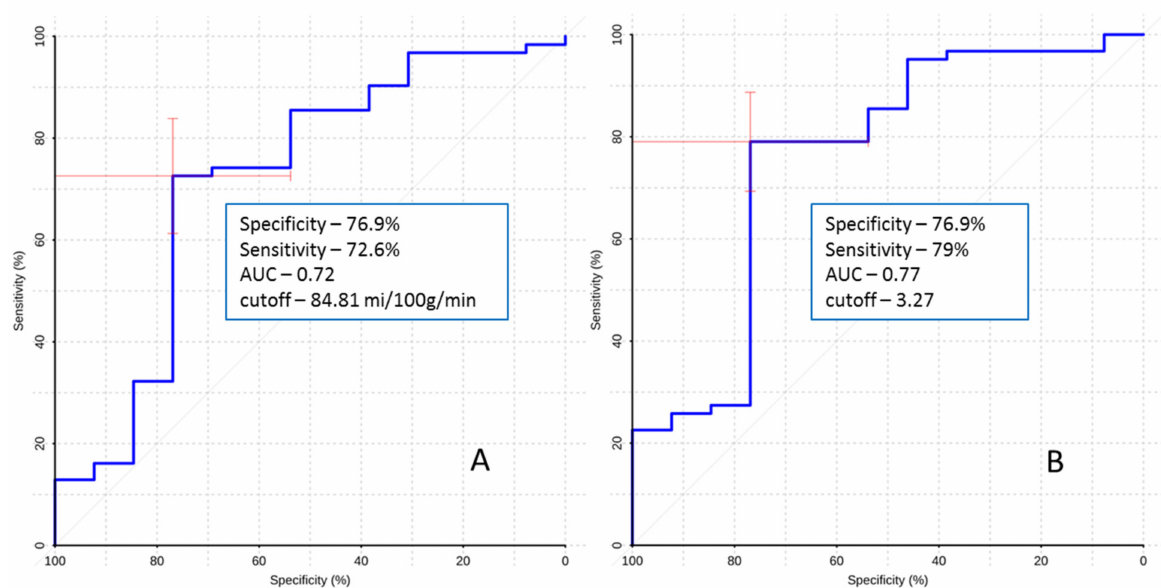
Figure 2. The ROC curve. Comparison of maximum blood flow ( A ) and maximum normalized blood flow ( B ) between fluorescent and non-fluorescent gliomas. AUC—area under curve.